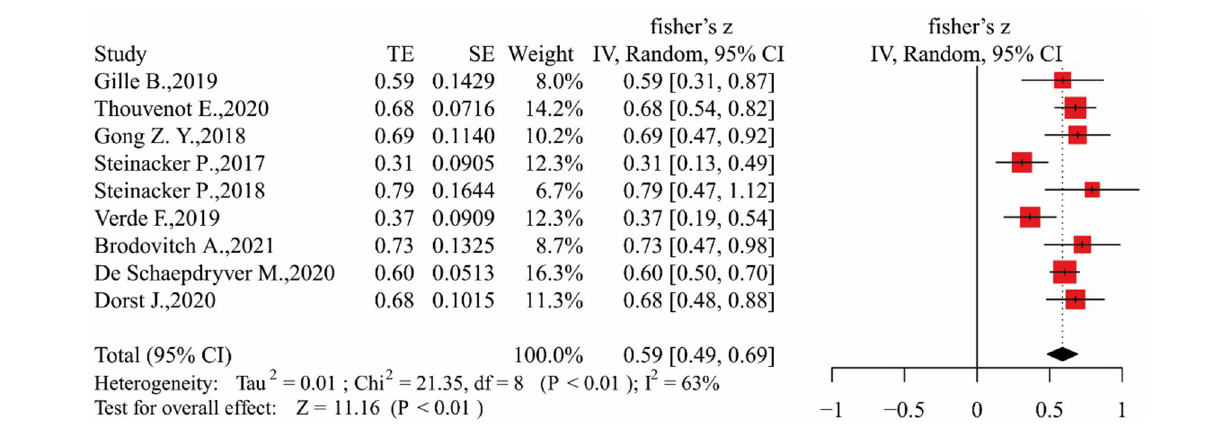
FIGURE 6 | Forest map showing the relationship between NfL levels and DPR.